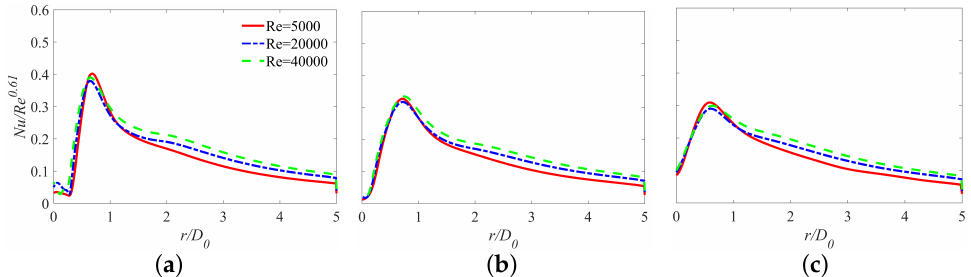
Figure 24. Nusselt number and Reynolds number scaling relationships for the diverging nozzle at ( a ) H = 0.5, ( b ) H = 2, and ( c ) H = 4.